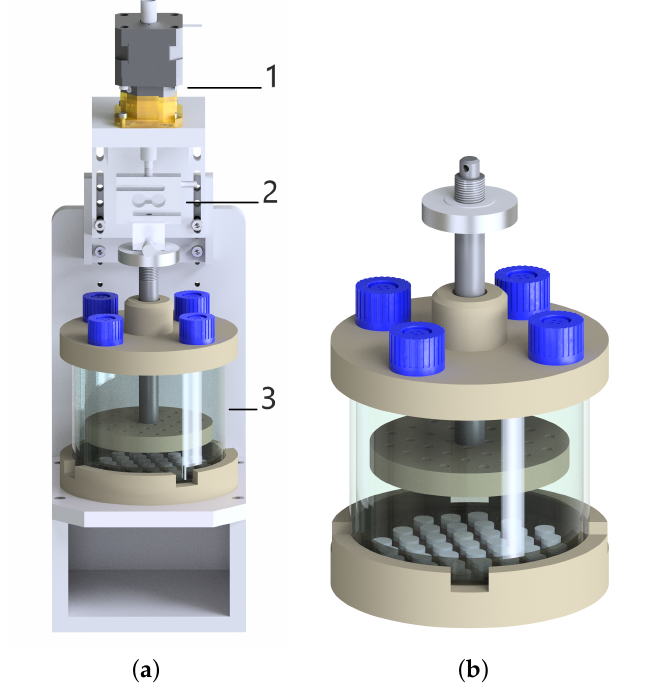
Figure 1. ( a ) The technical drawing of the compression bioreactor with its components: linear motor (1), load cell (2), and chamber (3). ( b ) More focus on the chamber with the petri dish including 37 samples and with the